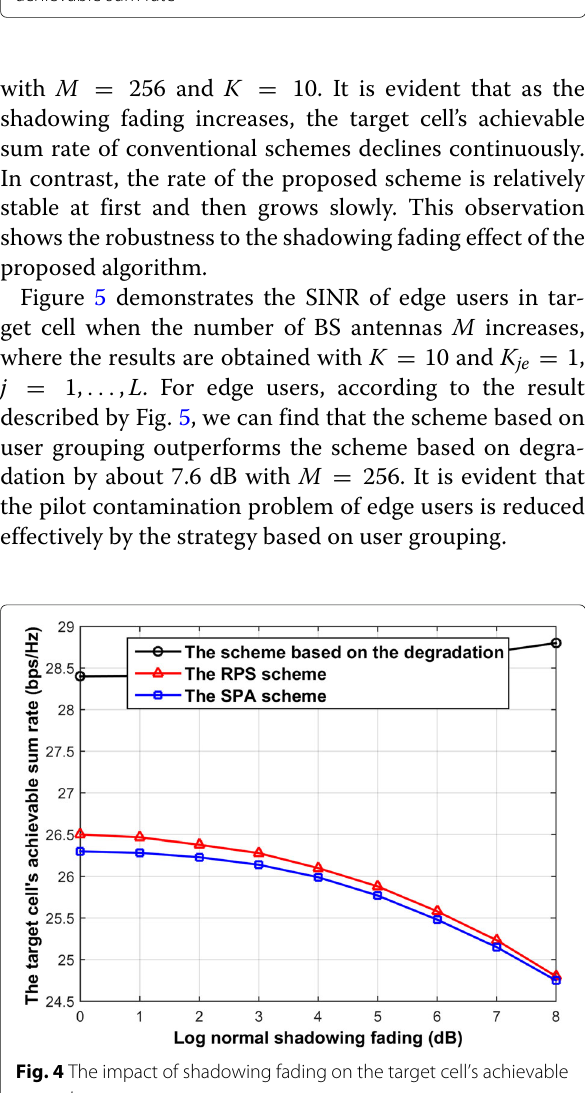
Fig. 3 The impact of the number BS antennas on the target cell’s achievable sum rate